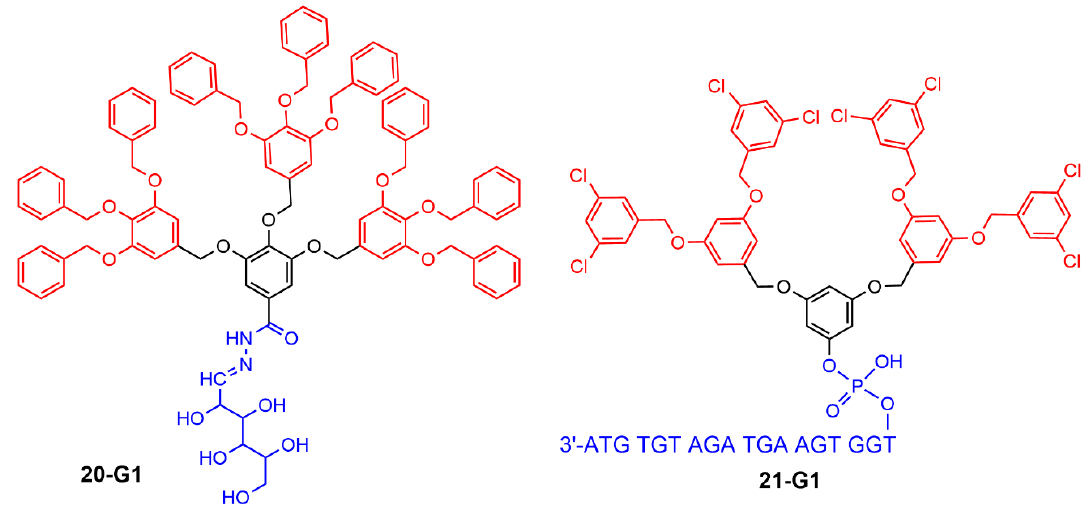
Figure 15. Structure of dendrons having a hydrophilic core and hydrophobic surface and branches.